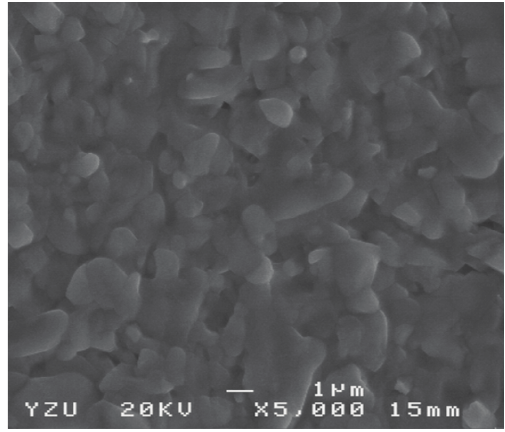
Figure 6: Surface SEM photographs of CIGS film layer.